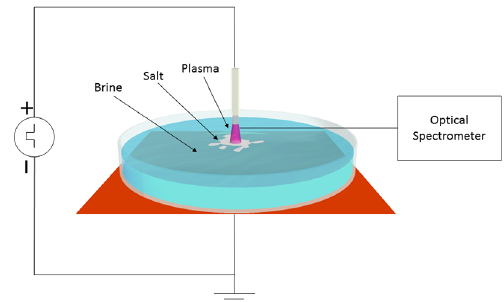
Figure 1. Apparatus to start the discharge on the surface of the brine.